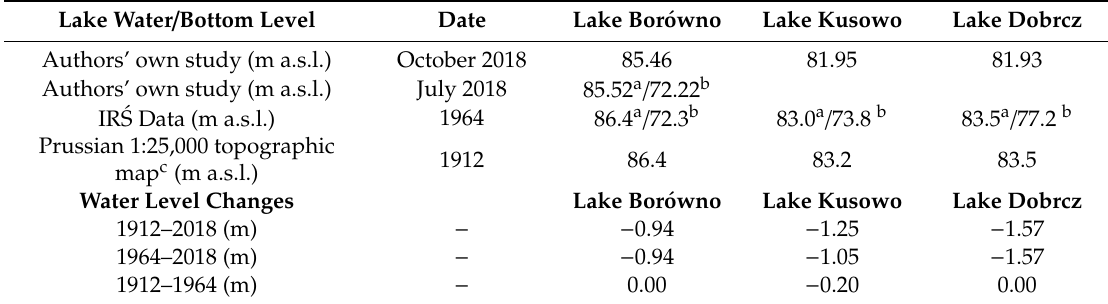
Table 5. Comparison of the altitudes of the water tables and the bottoms of Lakes Bor ó wno, Kusowo, and Dobrcz on the basis of various source materials [71,72], and own measurements. Lake Water / Bottom Level Lake Bor ó wno Lake Kusowo Authors’ own study (m a.s.l.) Authors’ own study (m a.s.l.) Prussian 1:25,000 topographic map c (m a.s.l.)